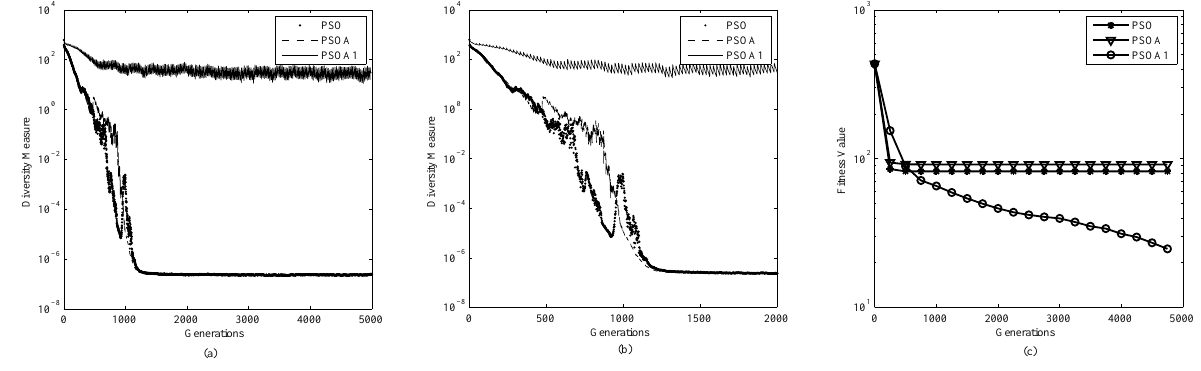
Figure 4: Comparision of PSO, PSOA and PSOA1’s diversity and convergence on the function Rastrigin f 4 . (a) diversity plot. (b) enlarged view of the diversity plot between 1 and 2000 generations. (c) convergence plot.